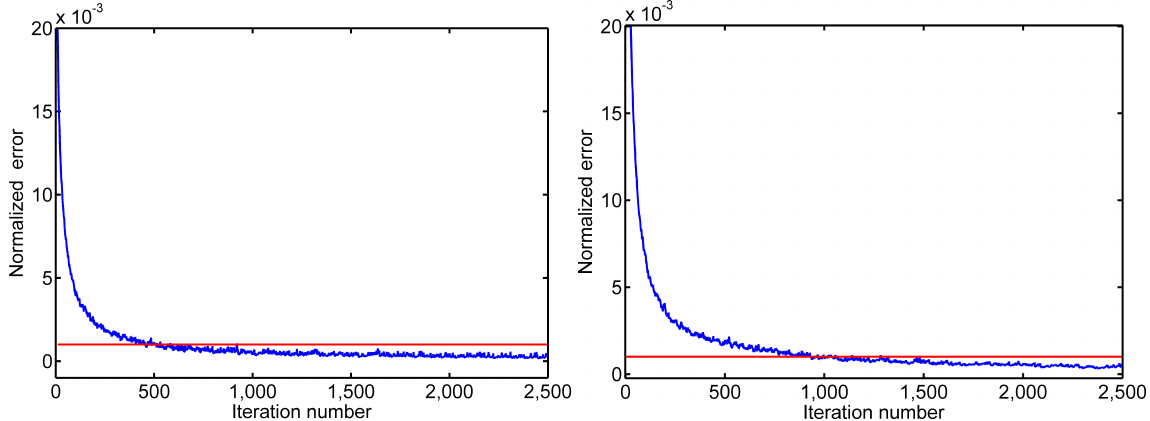
Figure 5. Normalized error as the iteration number increases: ( left ) for a large target using Log regularization; and ( right ) for a small target using L 1 / 2 , respectively. The red line indicates the 0.1%